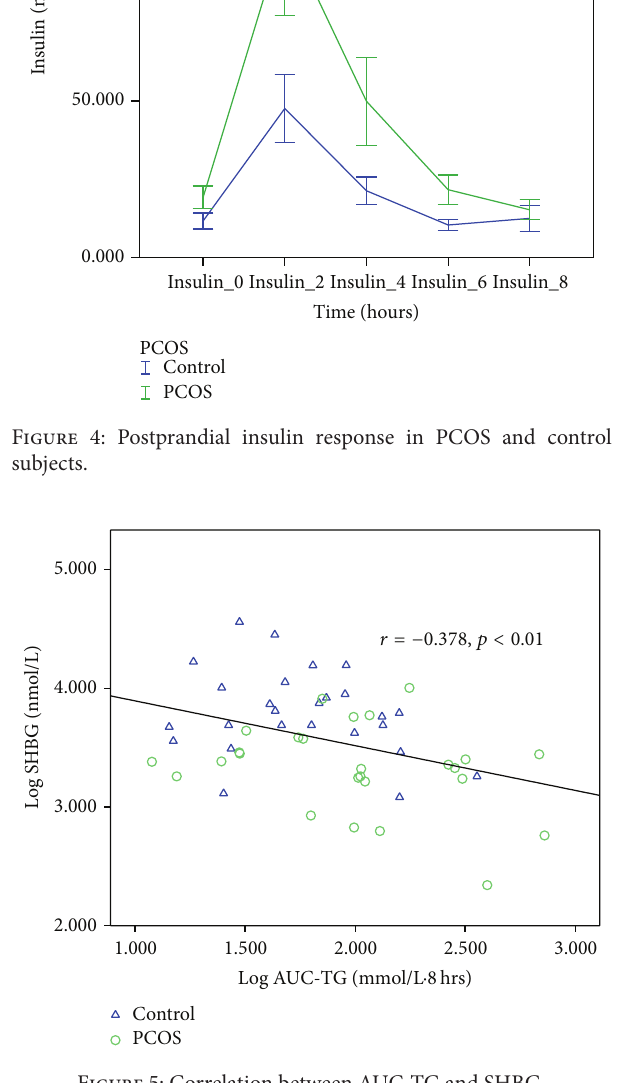
Figure 5: Correlation between AUC-TG and